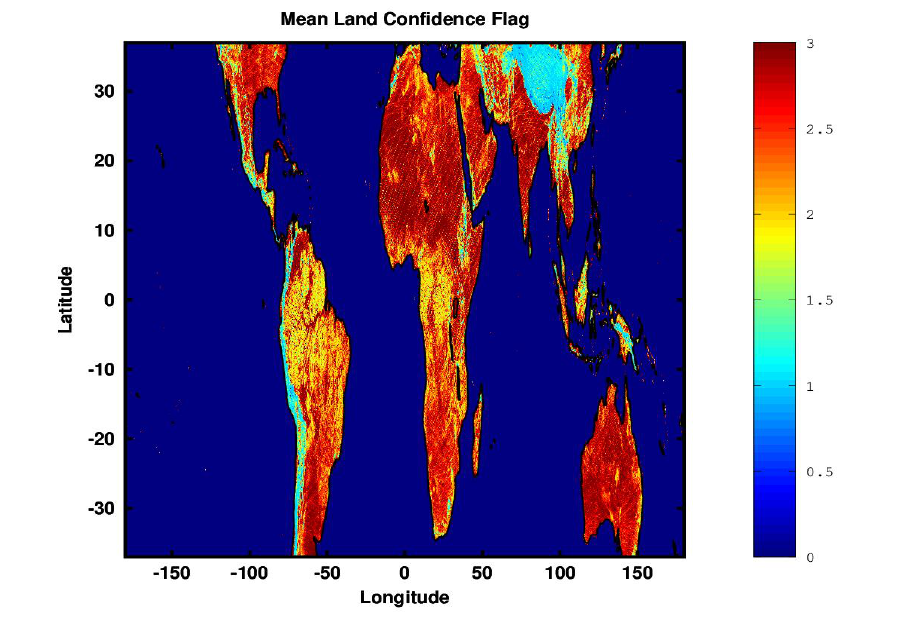
Figure 5. Map of land geolocation confidence flag. Confidence values range between 0 (lowest) and 3 (highest). As expected the general trend is that the estimated geolocation is of higher confidence over lower lying and more moderate terrain. It can also be observed that the geolocation often more difficult in dense forest regions (South America and Central Africa) due to the relatively lower SNR from these surfaces, which make the empirical signal peak checks more